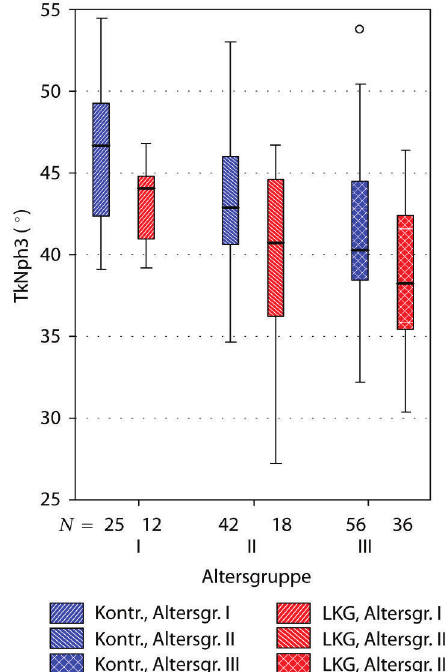
Figure 7: Boxplot illustrating significant di ff erences between uCLP group and controls concerning sagittal nasopharyngeal depth (dis- tance Ba-Spp). “Altersgruppe”: age subgroups, explanation see Table 1. “LKG”: uCLP group (cleft). “Kontr.”: control group (non- cleft).